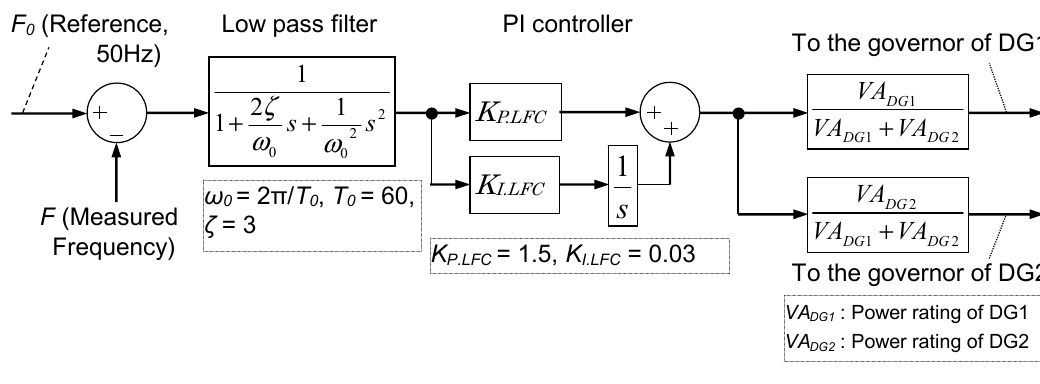
Figure 3. Model of a load frequency control (LFC).